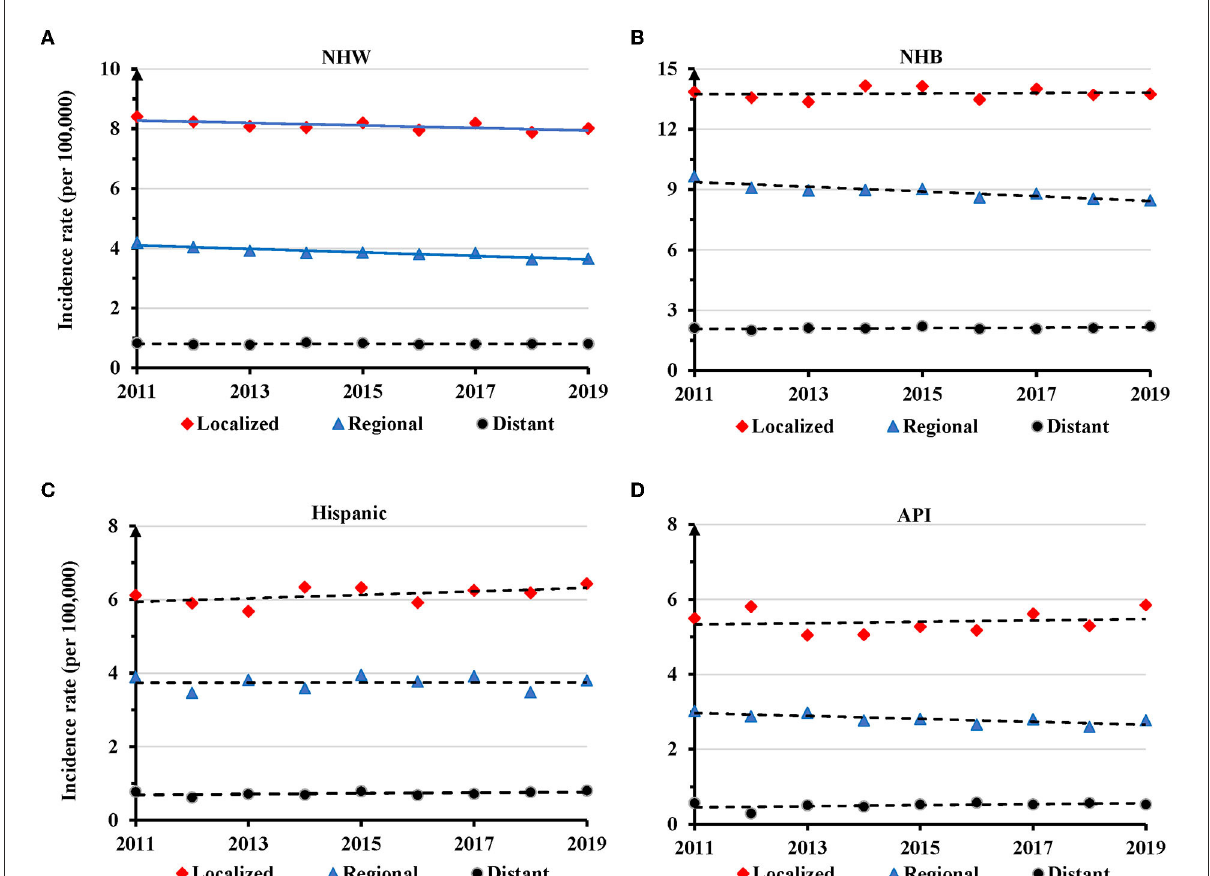
FIGURE6 Temporal changes in age adjusted incidence rate of TNBC by disease stage in individual races during 2011–2019. (A) Non-Hispanic White (NHW). (B) Non-Hispanic Black (NHB). (C) Hispanic. (D) Asian or Pacific Islander (API). Solid lines indicate significant change in annual percentage change (APC) of age adjusted incidence rates. Dashed lines show no significant